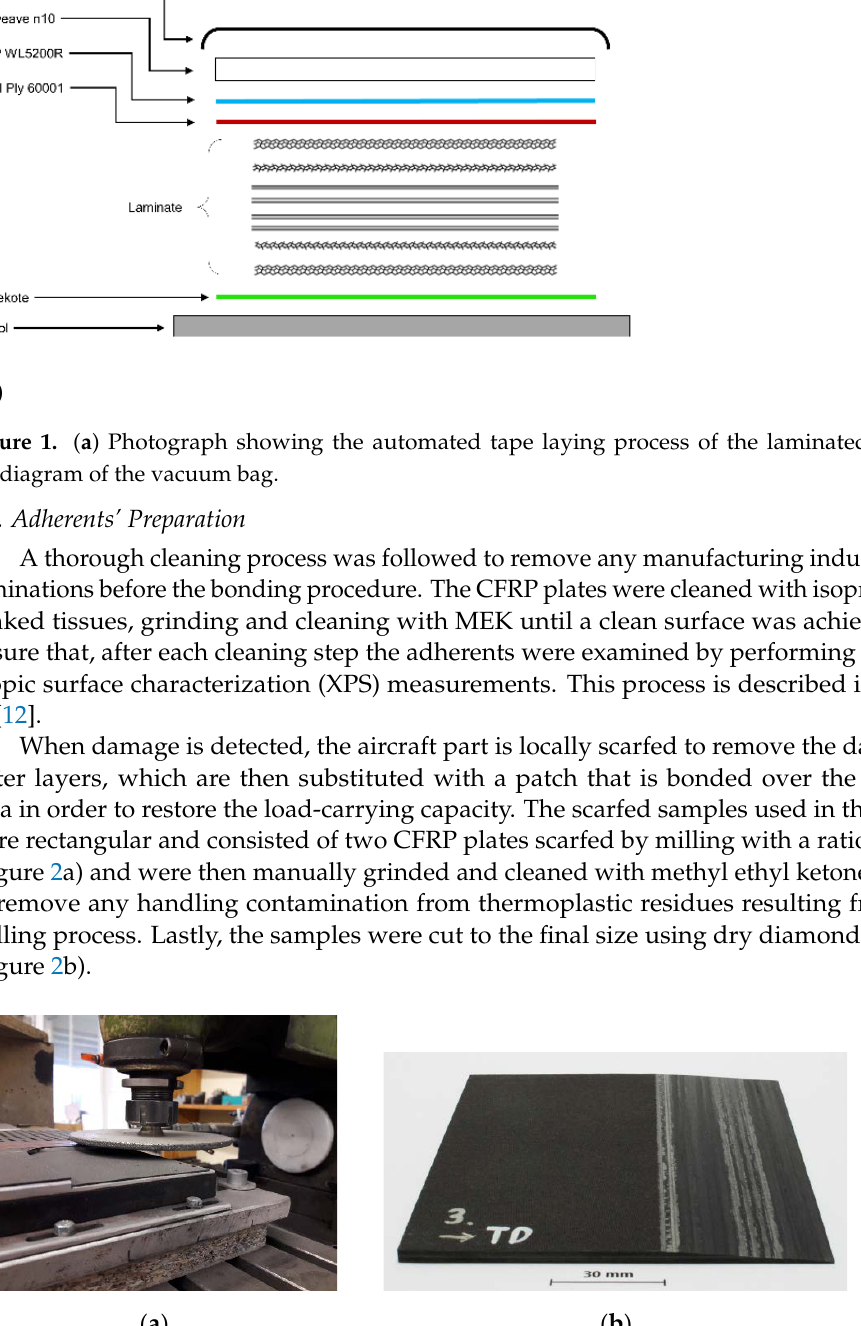
Figure 2. ( a ) Milling device; ( b ) overview of scarfed sample after milling.